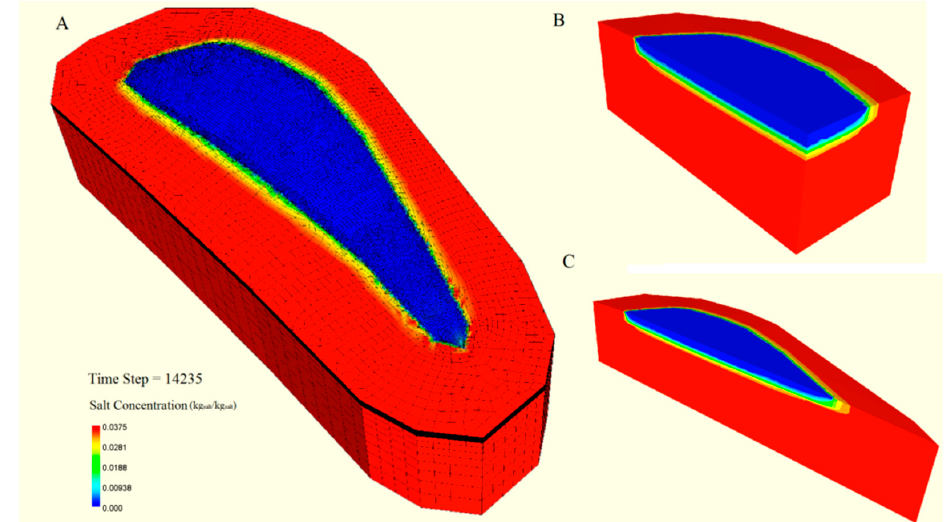
Figure 7. Three-dimensional view of the SUTRA finite element mesh for Gan Island for year 2050, showing the spatial distribution of salt concentration in the aquifer. Red represents the salinity concentration of seawater, and blue represents freshwater (i.e., salinity concentration = 0), with other colors representing the transition zone. ( A ) shows the horizontal extent of the freshwater lens on the island, and ( B ) and ( C ) show cross sections of the freshwater lens through the longitudinal and transverse lines of the island.